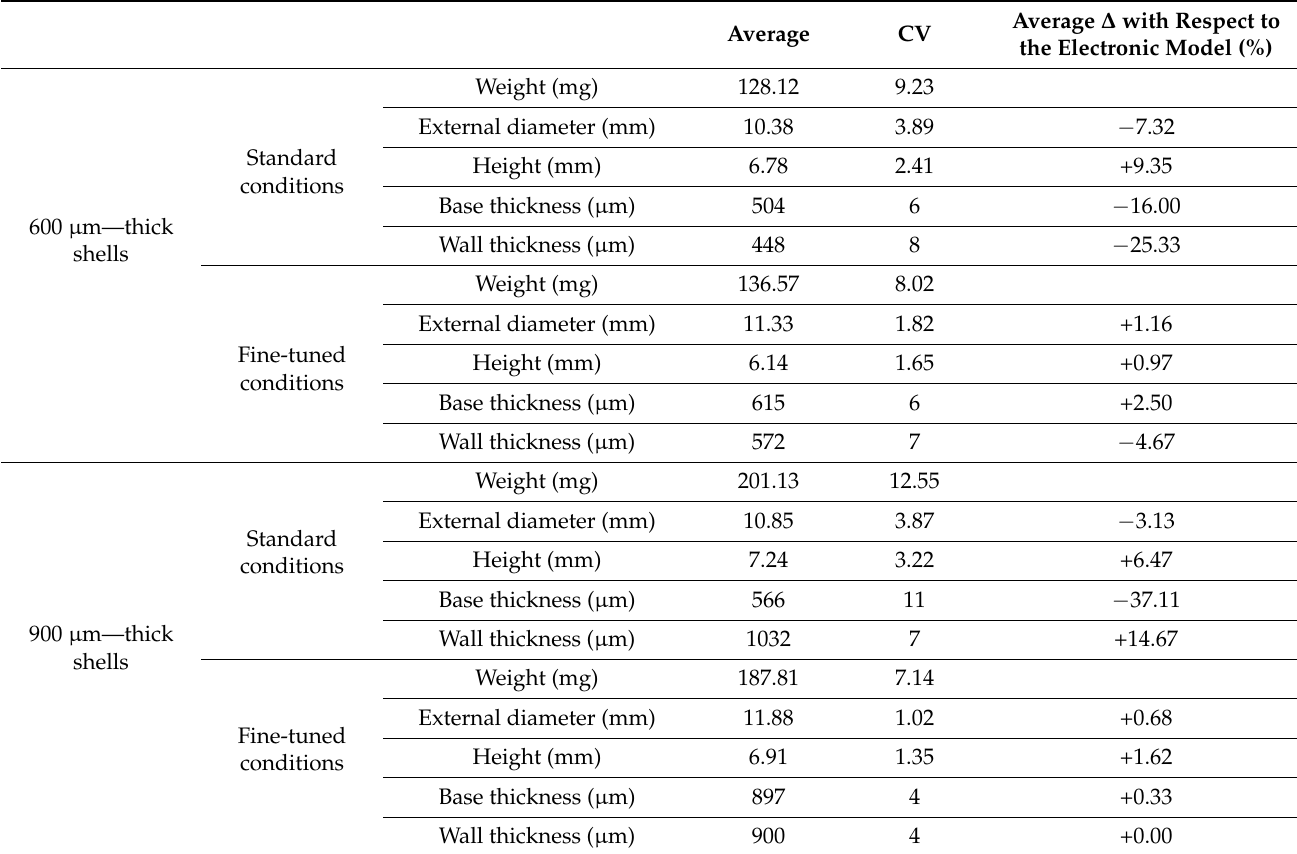
Table 2. Weight and dimension characteristics of HPC-based shells.